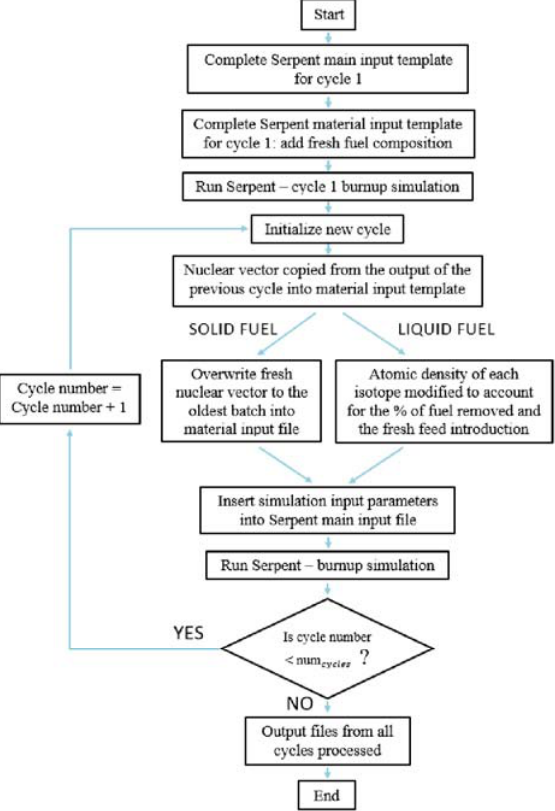
Figure 2 . BBP conceptual